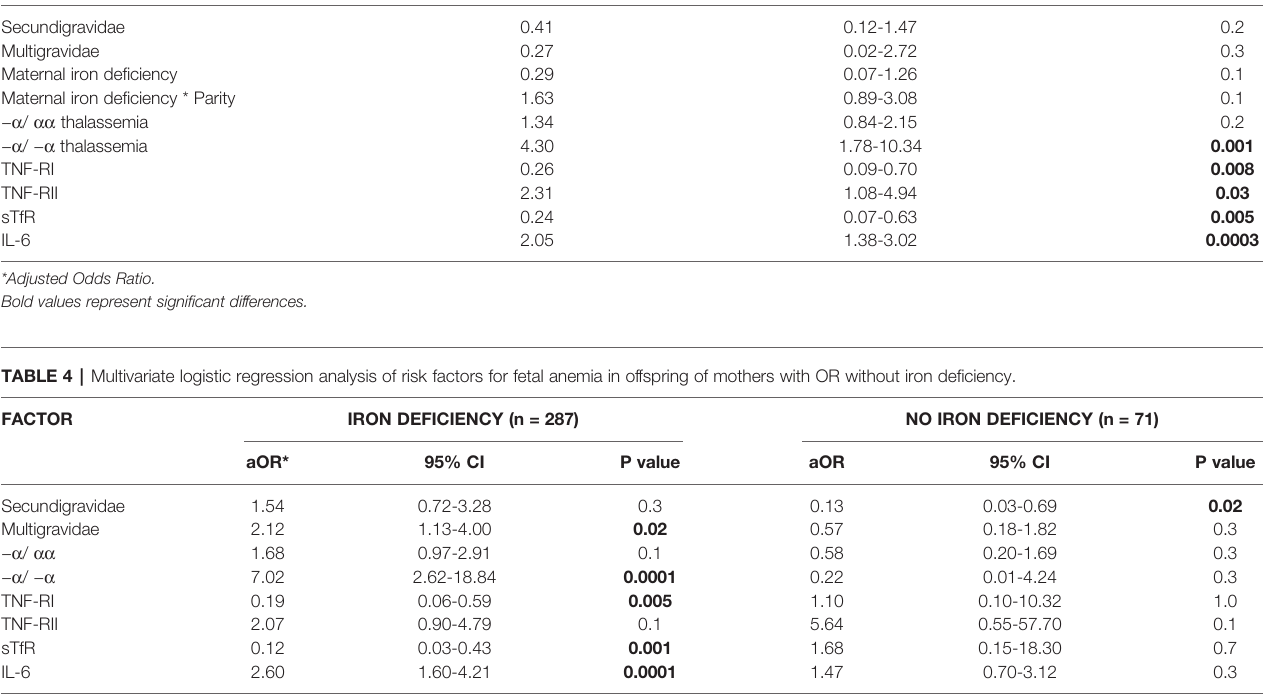
*Adjusted Odds Ratio. Bold values represent signi fi cant